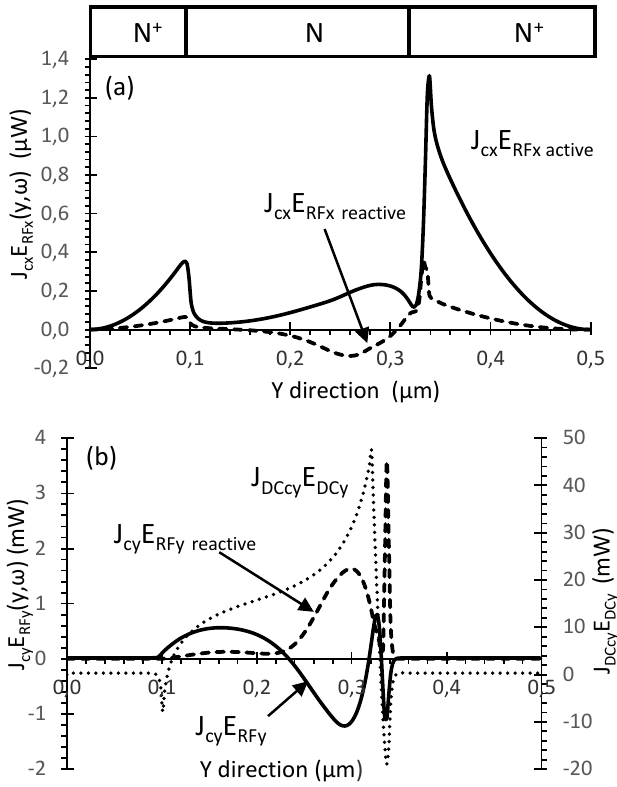
Figure 17: Y direction spatial evolution of the different terms constituting the electron power at the fundamental frequency ω at x=130 µm The usable EM power delivered by the oscillator only results from the EM energy propagation in the x direction.